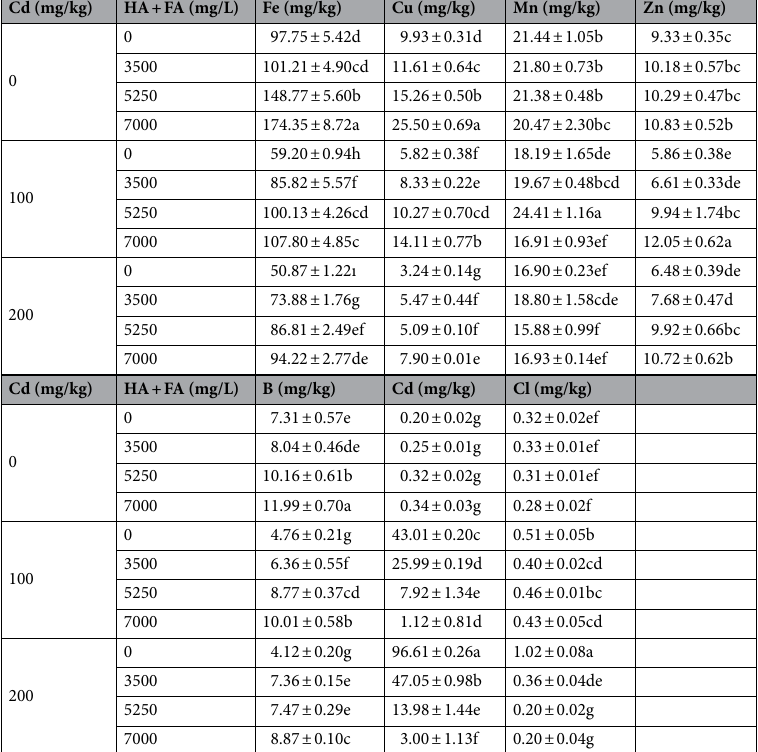
Table 5. Effect of cadmium and HA applications on micro element content of garden cress. The difference between the means indicated by different letters in the same column is statistically significant (Duncan multiple comparison test, P <